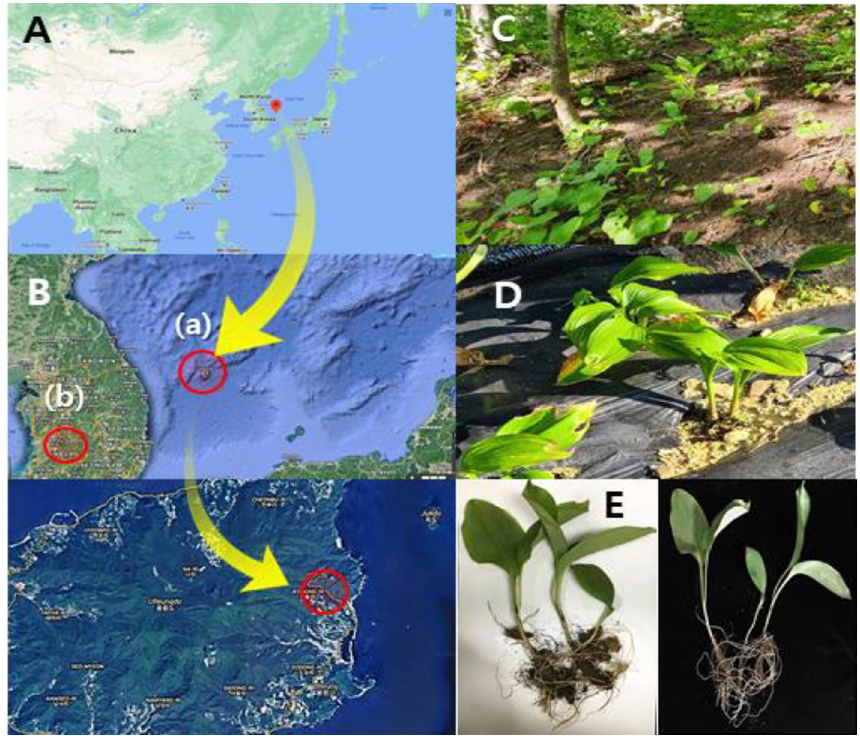
Figure 1. Sampling sites and Ulleung-sanmaneul plants. The endemic plants collected from native habitats and cultivated fields located (red dot) in Ulleung island, Gyeongsangbuk-do ( A,B-a,C ) and a medicinal herb experiment station, Jinan-gun, Jeollabuk-do ( B-b,D ), respectively. The plants ( E ) collected from native (left) and cultivated (right) areas for microbe profiling. The images ( A,B ) were obtained from https:// www. google. co.